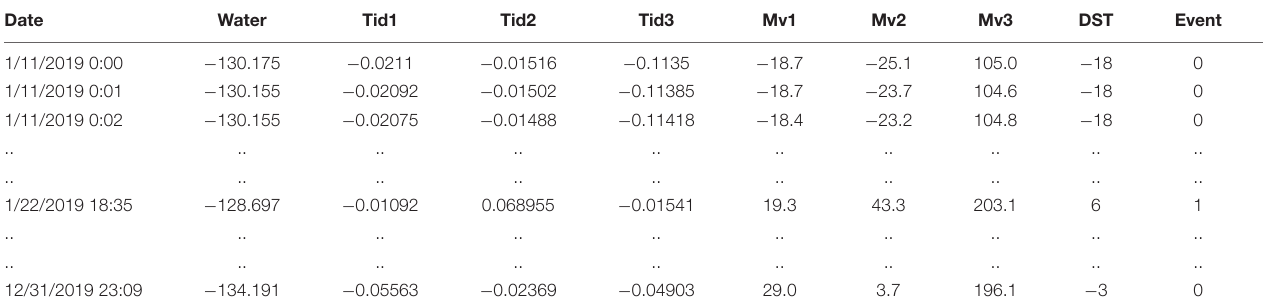
TABLE 3 | One-minute values of predictors and correction factors: water level in the well, tidal variations’ components, magnetic field components, geomagnetic DST index, and